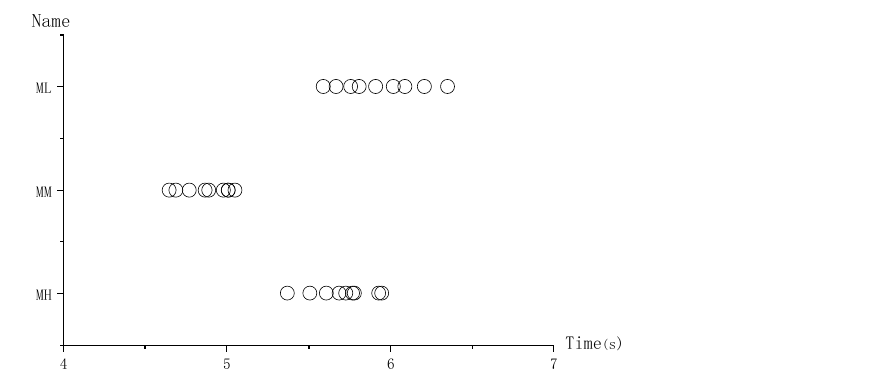
Figure 16. Scatter plot of the response time for each height of the medium-pitched indication.